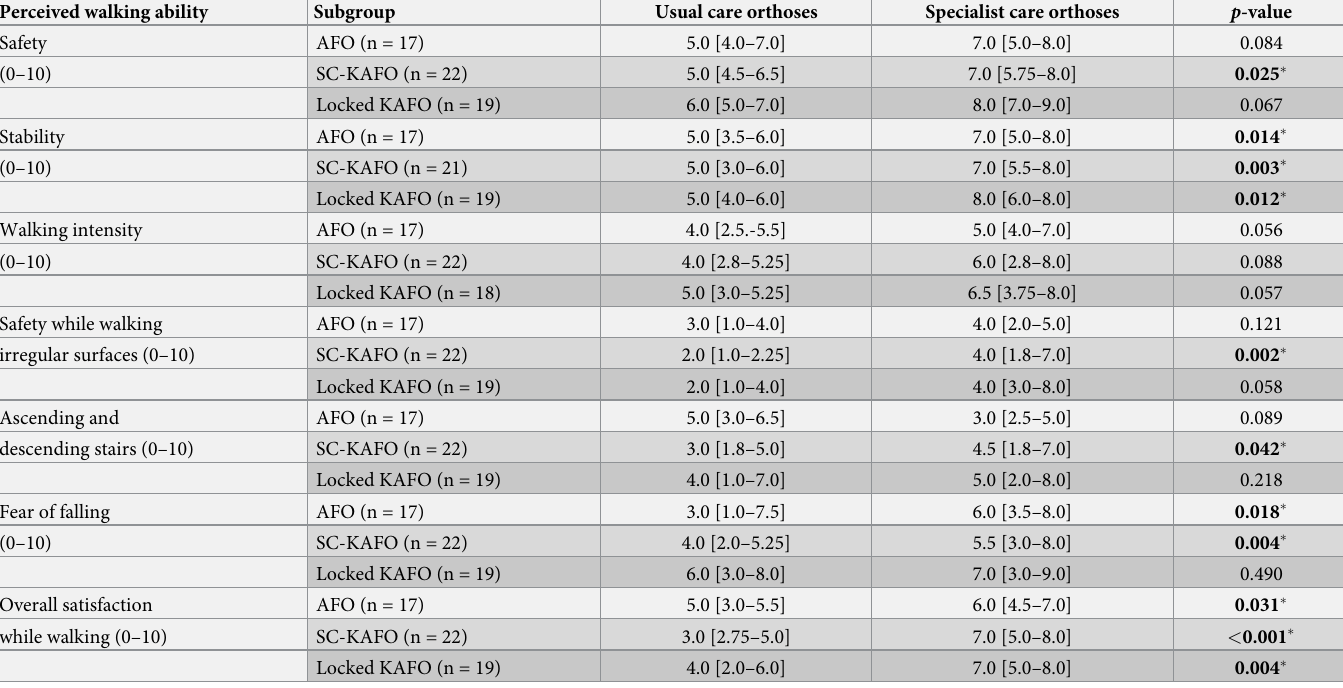
Table 3. Results for perceived walking ability for UC orthoses and specialist care orthoses in subgroups of subjects provided with specialist care AFOs, SC-KAFOs and locked KAFOs. Perceived walking